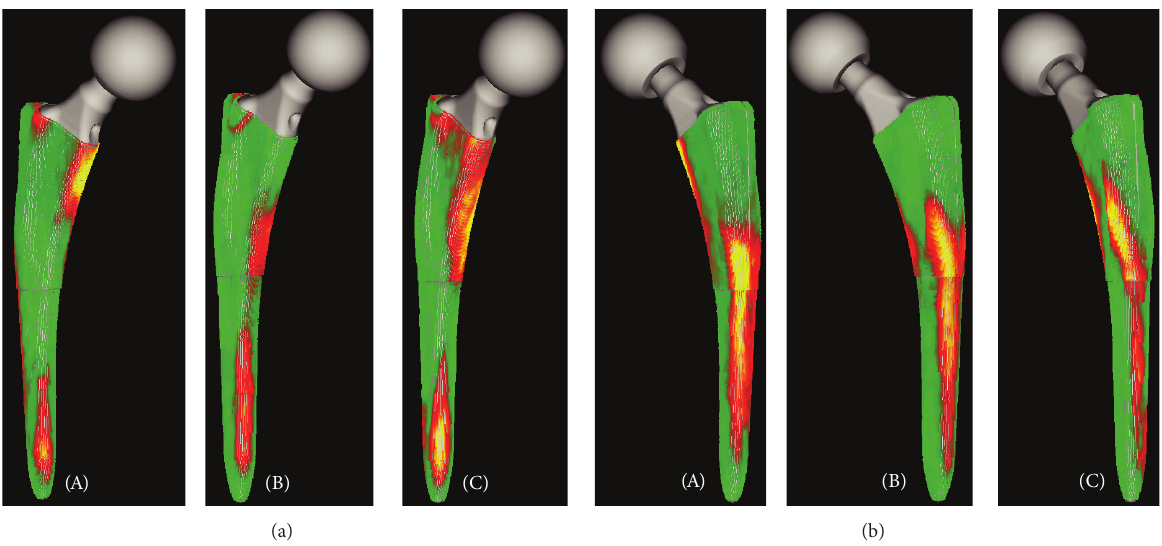
Figure 5: Posteromedial (a) and anterolateral (b) views of stems in contact with the cortical bone at the medial side of the proximal (A), middle (B), and both (C)